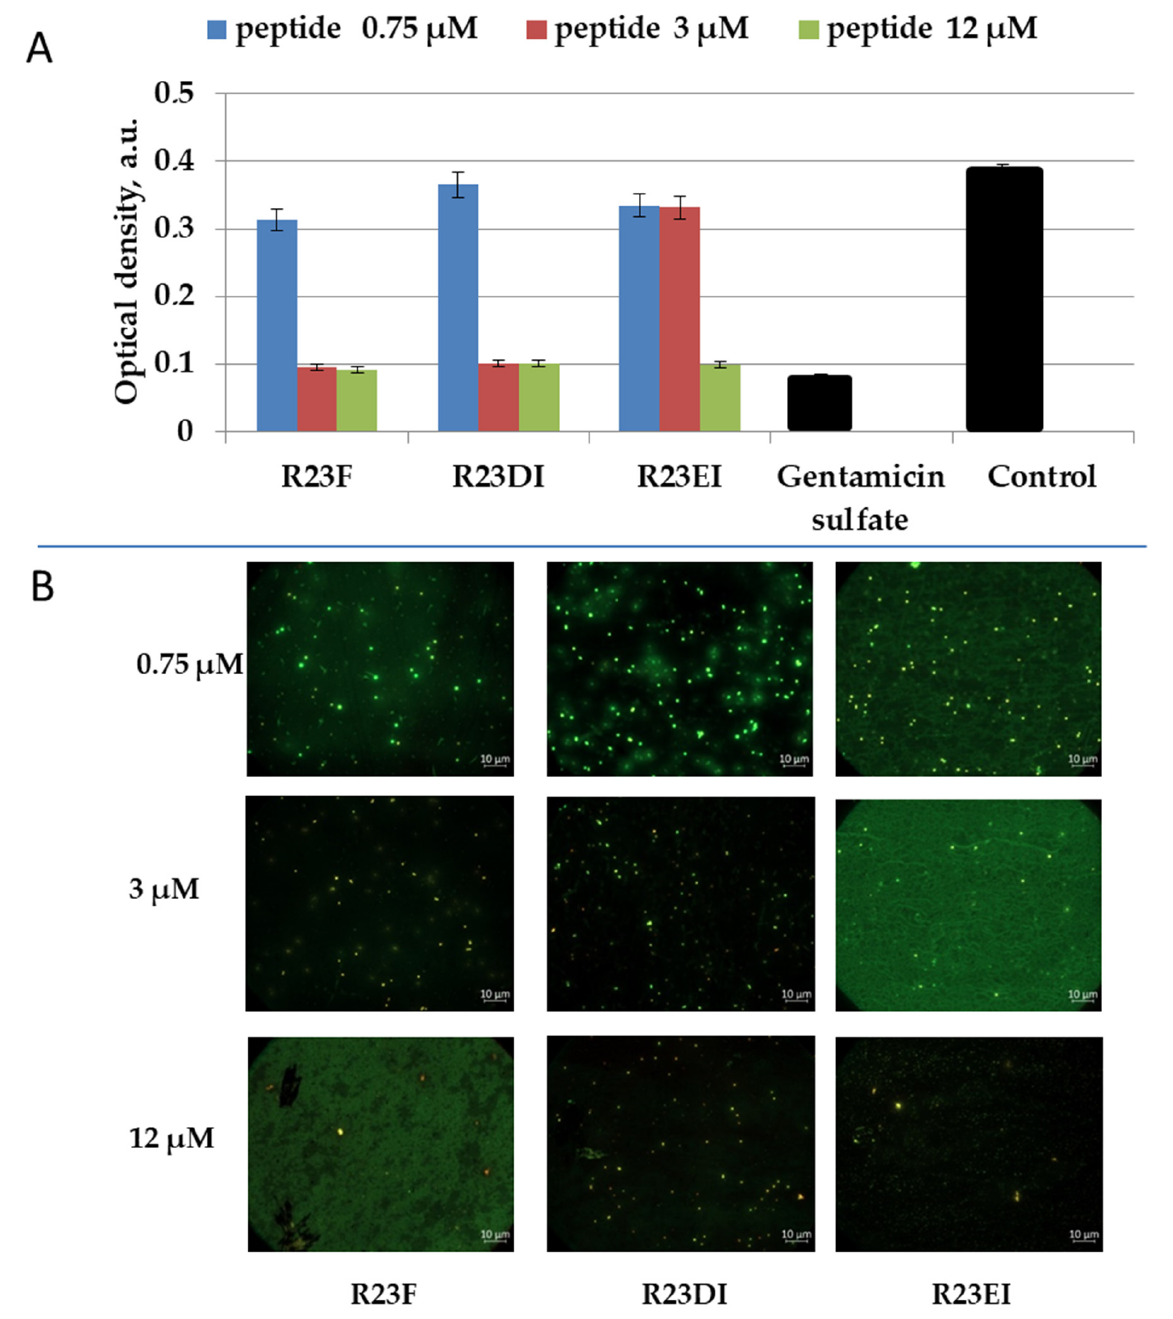
Figure 10. Antimicrobial action of peptides against S. aureus cells (209P strain) ( A ). Fluorescence microscopic images of S. aureus cells (209P strain) treated with peptides R23F, R23DI, and R23EI ( B ). A gentamicin sulfate concentration of 1700 µ M was used as a positive control for the antimicrobial effect. Bacterial cells stained with SYTO 9 and propidium iodide, but fluorescence signal of SYTO 9 is visible only since the cells are not dead, but growth of bacterial cells is inhibited. The experiments were performed in two replicates. The results were expressed as the mean ± standard deviation (M ± SD).